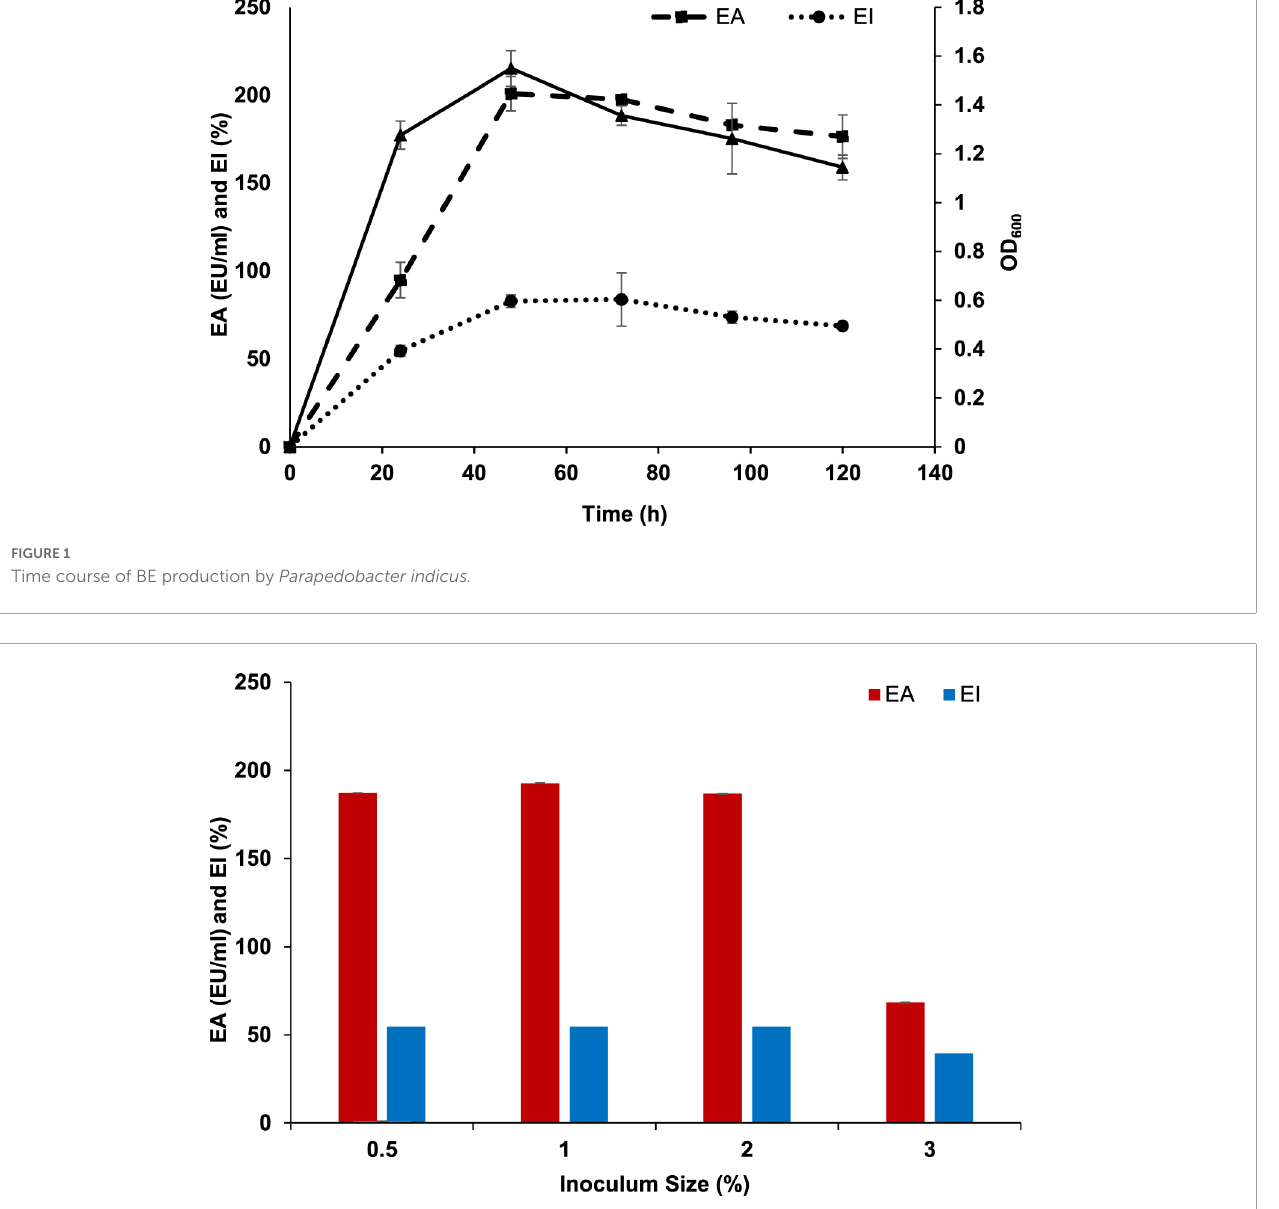
FIGURE2 Effect of inoculum size on BE production by Parapedobacter